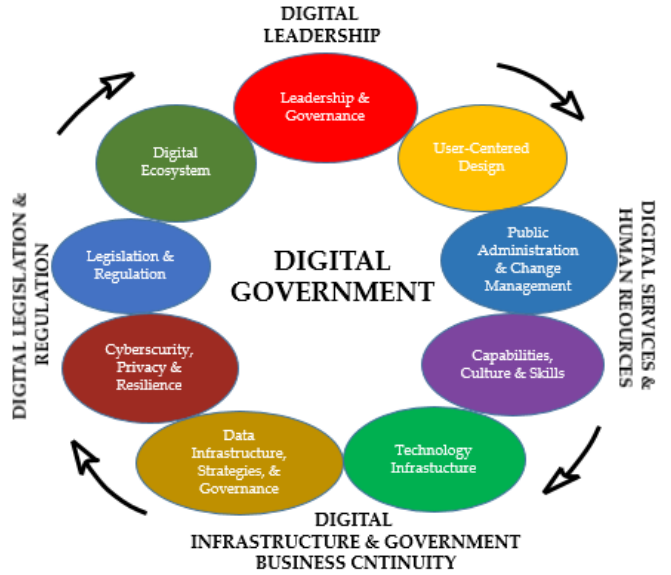
Figure 1. The nine core groups of the Digital Governance Assessment Framework (DGRA), redrawn from [21].